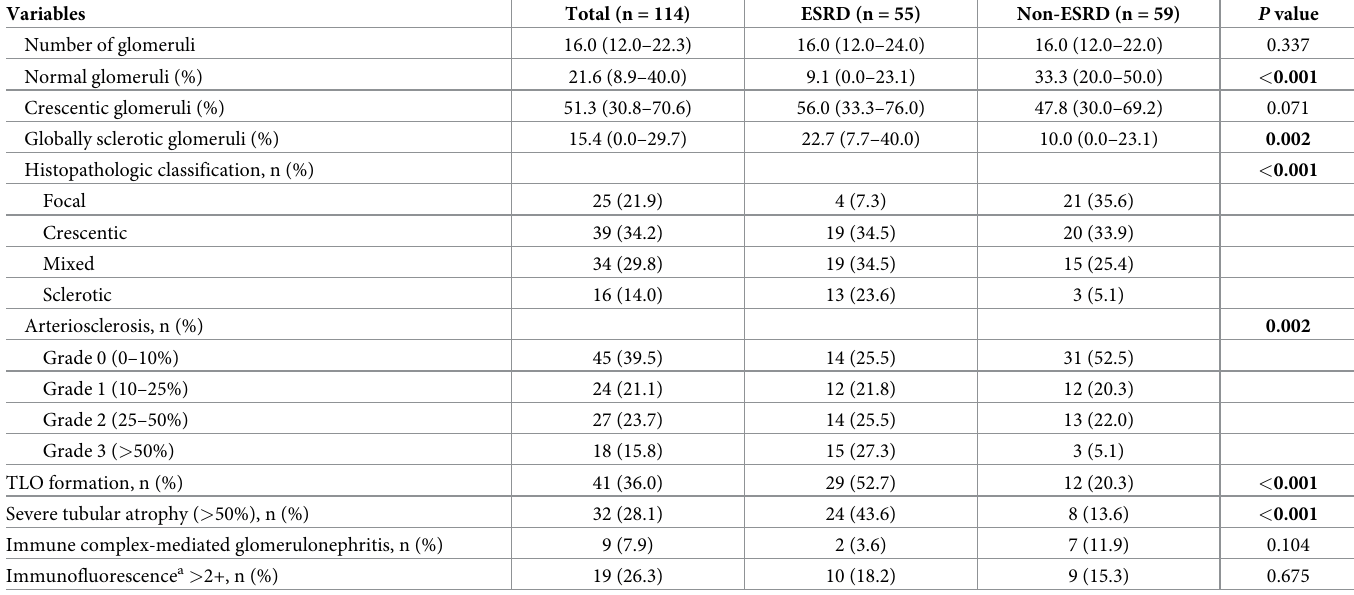
antibody; nine patients (7.9%) had immune complex-mediated glomerulonephritis, such as membranoproliferative glomerulonephritis (3 patients), IgA nephropathy (5 patients), and lupus nephritis (1 patient) (S1 Table). During the median follow-up of 458.0 (IQR, 92.5– 1254.5) days, 55 patients (48.2%) reached end-stage renal disease (ESRD). The positive ratios for ANCA and anti-GBM antibody were similar between ESRD and non-ESRD patients. Patients who progressed to ESRD were older than non-ESRD patients ( P = 0.037) and were more likely to have comorbid hypertension at the time of diagnosis ( P = 0.026). Mean baseline blood urea nitrogen and serum creatinine levels were higher and eGFR was lower among ESRD patients (all P < 0.001), but there was no between-group difference in terms of C-reactive protein level. The median number of glomeruli in the specimens was 16.0 (IQR, 12.0–22.3), and patients with ESRD had a lower proportion of normal glomeruli and a higher proportion of globally sclerotic glomeruli compared with non-ESRD patients (both P < 0.05). According to the histo- pathologic classification, 25 specimens (21.9%) were classified as focal, 39 (34.2%) were crescen- tic, 34 (29.8%) were mixed, and 16 (14.0%) were sclerotic. Sclerotic specimens were more common among patients who progressed to ESRD, and the focal specimens were more com- mon among patients who did not progress to ESRD. Severe arteriosclerosis, TLO formation, and severe tubular atrophy were more common among patients with ESRD (all P < 0.05). Nine- teen patients showed > 2+ staining with immunofluorescence antibody to at least one of the fol- lowings: IgG, IgA, IgM, C3, and fibrinogen. A detailed information on immunofluorescence are shown in S1